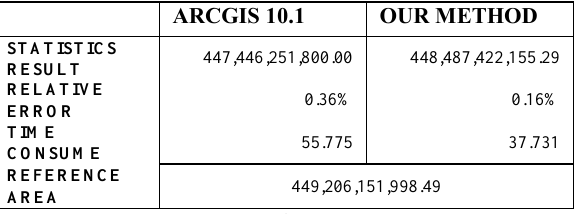
Table 1. Result of the accuracy test